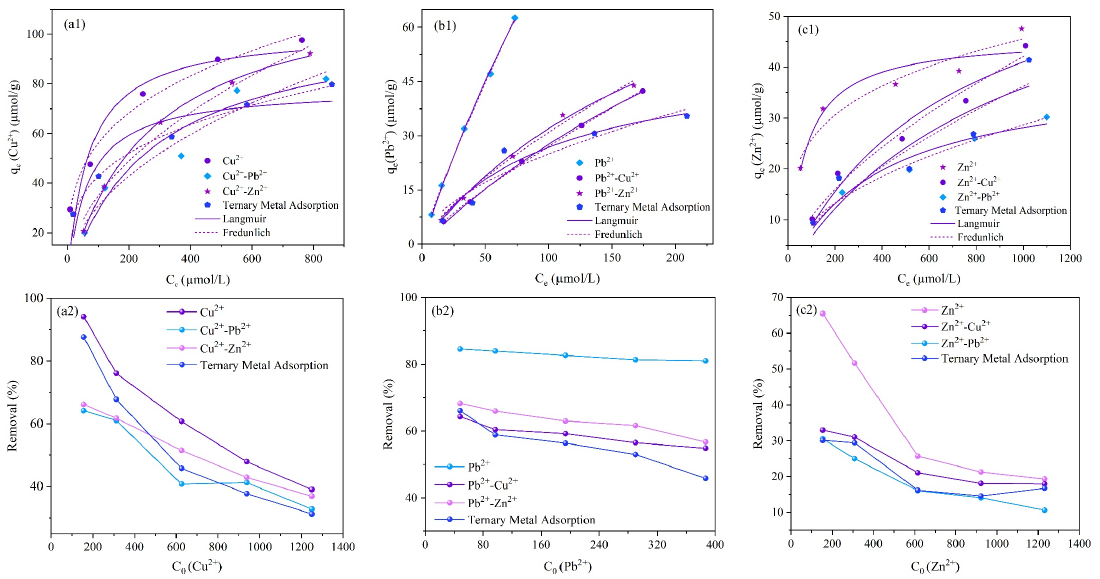
Figure 6. Fitting results of Langmuir and Freundlich isothermal adsorption models of Cu 2+ ( a1 ), Pb 2+